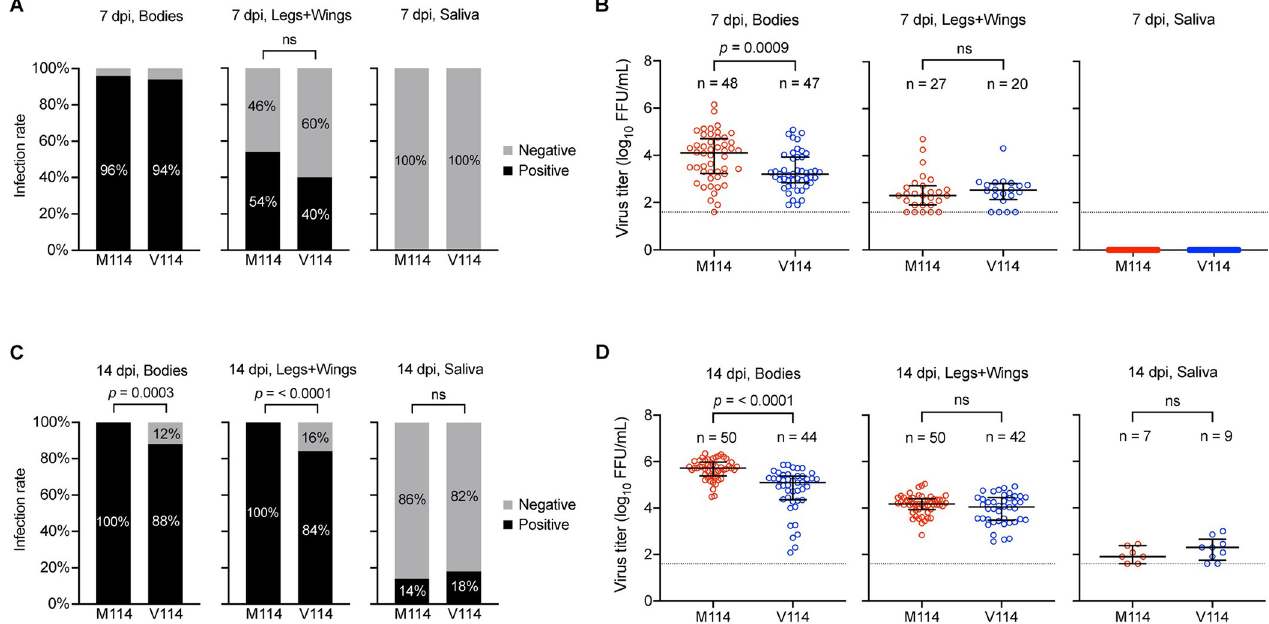
Fig 5. The ZIKV NS5-M114V mutation reduced infection and dissemination rates in Aedes aegypti mosquitoes but had no effect on virus secretion into the saliva. Female Ae . aegypti mosquitoes were exposed to infectious blood meals containing respective ZIKV strains at 10 8 FFU/mL. Infected mosquitoes’ bodies, legs and wings, saliva expectorates (n = 50/group) were harvested at ( A , B ) 7 days post-infection (dpi) and ( C , D ) 14 dpi for infectious virus particle titration using immuno-plaque assay (iPA). To determine the infection rate of each strain at 7 dpi ( A ) and 14 dpi ( C ), the number of respective ZIKV-positive bodies, legs and wings, and saliva expectorates were measured and expressed as percentages for comparison. To determine the efficiency of virus replication, dissemination and transmission potential, viral titers from ZIKV-positive bodies, legs and wings, and saliva expectorates at 7 dpi ( B ) and 14 dpi ( D ) were quantified and expressed as log 10 transformed FFU/mL. Horizontal lines indicate the median and interquartile ranges of individual viral titer values and dotted lines indicate the limit of detection of the assay (1.6 log 10 FFU/mL). Statistical significance was determined using chi-squared ( A , C ) or Mann-Whitney U tests ( B , D ). All p -values indicated are two-sided, with no multiple comparisons performed in each test.